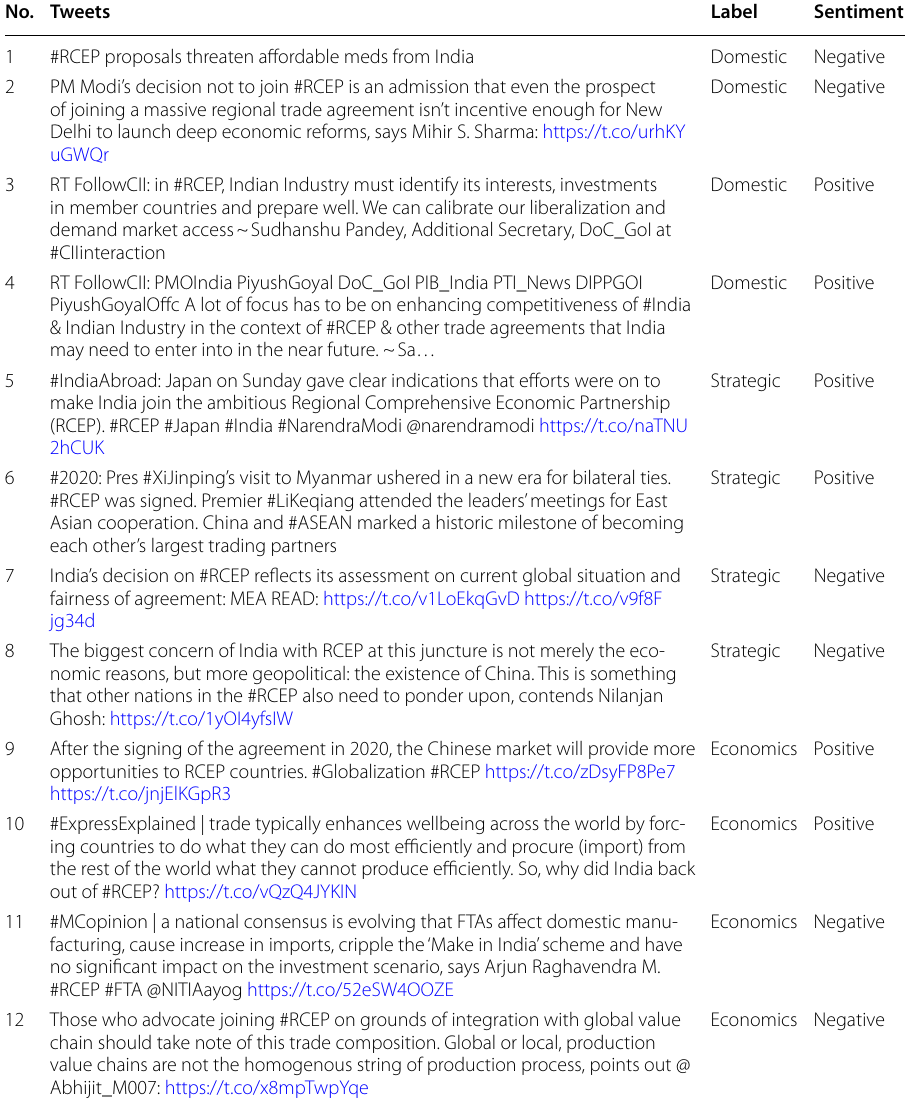
Table 1 Labelling for topic classification and sentiment No. Tweets Label